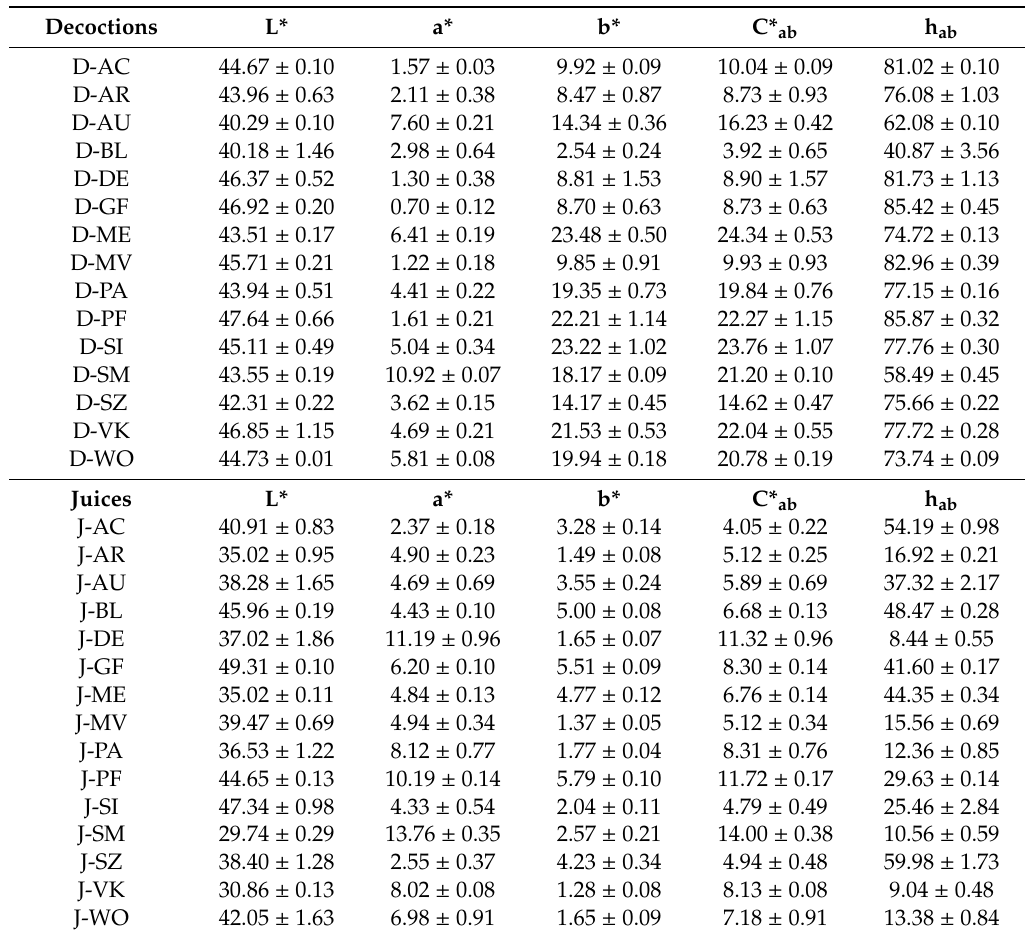
Table 5. Colorimetric data from CIEL*a*b* measurement of the pomegranate juices and decoctions. Results are reported as mean ± SD from three independent